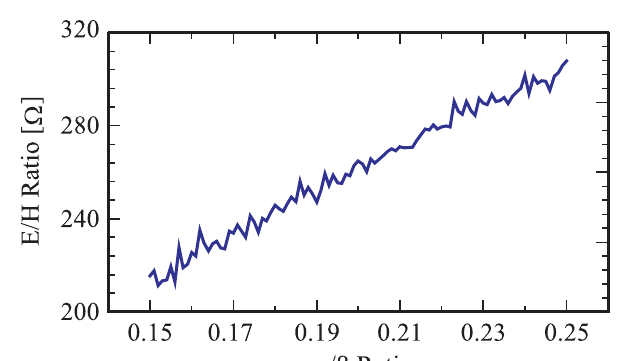
FIG. 3. Peak surface electric field to peak surface magnetic field ratio ( E = H ratio) versus (cid:1)=(cid:2) ratio as calculated using HFSS